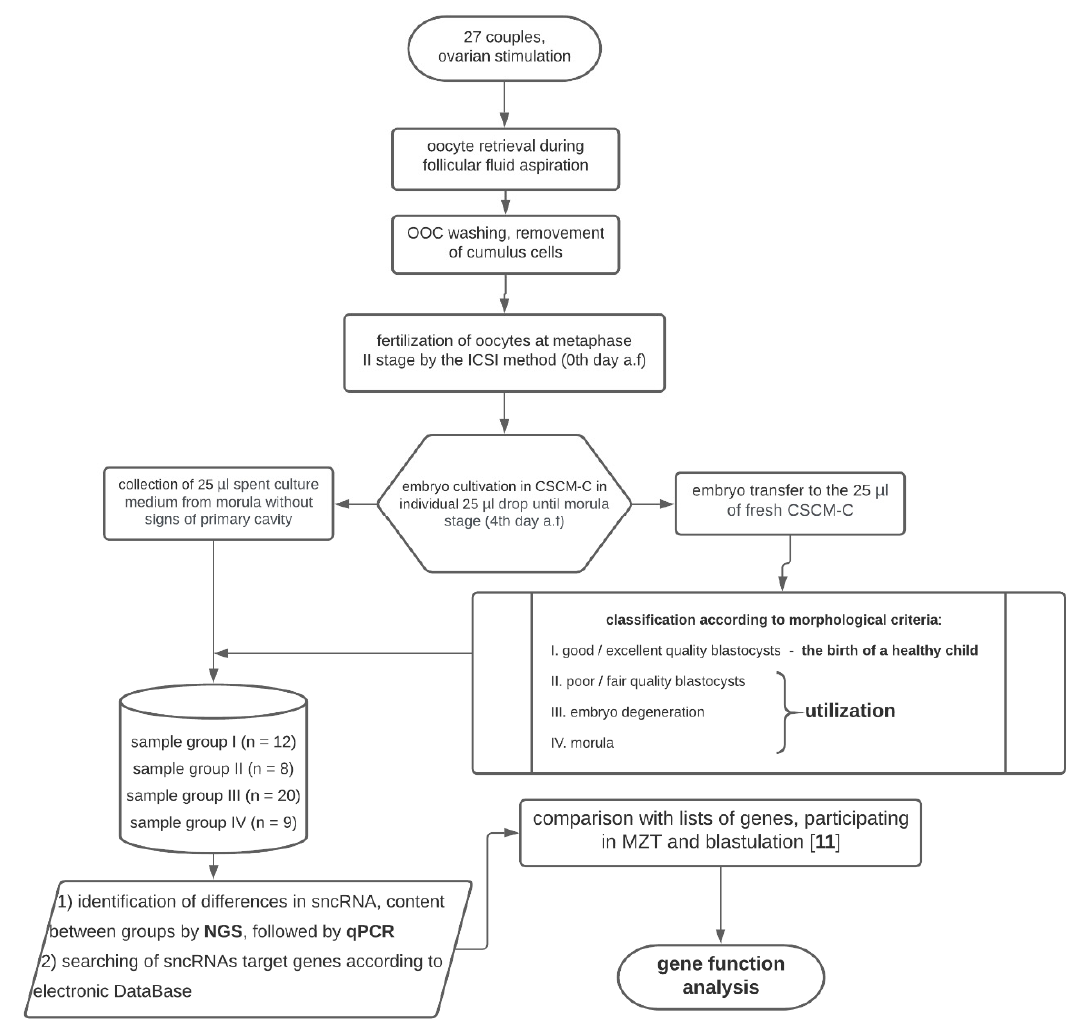
Figure 4. Flow diagram of the experimental design.